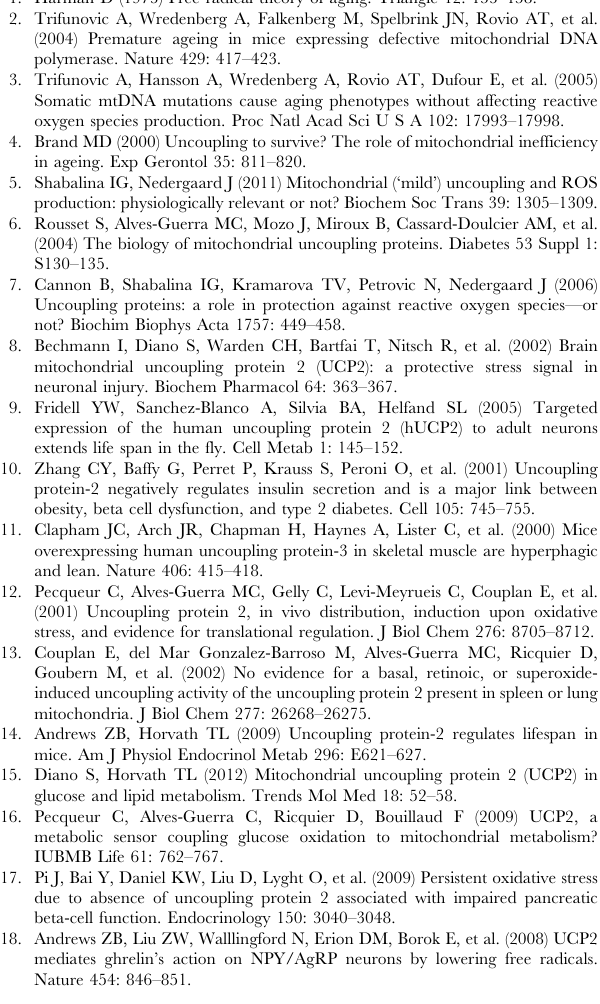
differences between mut and dm are presented with thick lines.